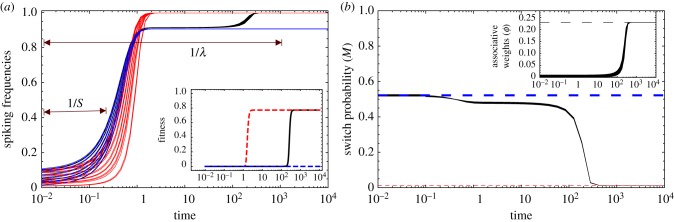
Example of selection-learning dynamics. (a) Selection-learning dynamics (black lines) compared with standard mutation selection with naive switching probabilities (M ∼ 1/2; blue) and with the run with the switching probabilities already learnt (red). Note that initially the blue and black lines overlap. Inset: evolution of fitness. (b) Evolution of the switching probabilities. Inset: evolution of Hebbian weights. n = 20, S = 5, λ = 0.001. Initial conditions for spiking probabilities and for initial weights are randomly sampled from a uniform distribution U[0, 0.01]. The learning network is fully connected. Note the log time scale.